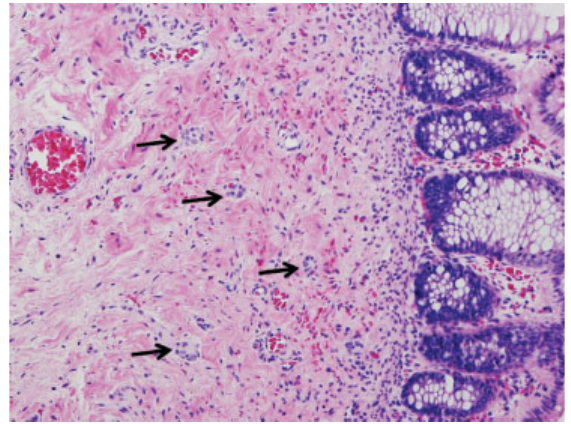
Fig. 1 H&E stain ( (cid:1) 100). Representative example of a normal suction rectal biopsy with several groups of ganglion cells seen in the